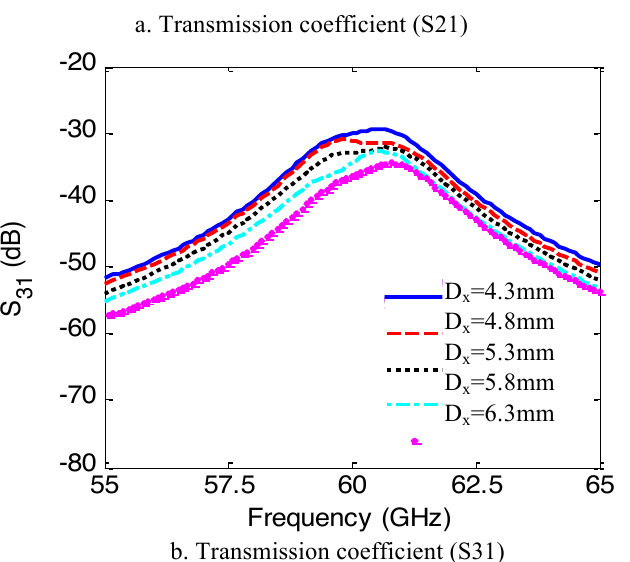
Fig. 11. The transmission coefficient between the CP- microstrip patch on-chip antenna (port 1) and the dual- polarized microstrip patch on-chip antenna (Y-port (2) and X-port (3)) versus frequency for different separation distance D.